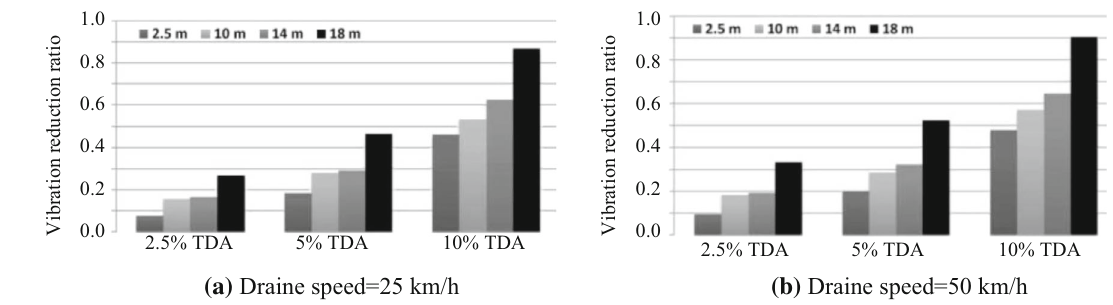
Fig. 5 TDA effect on V RMS outputs under the passage of draisine a at 25 km/h speed and b at 50 km/h speed